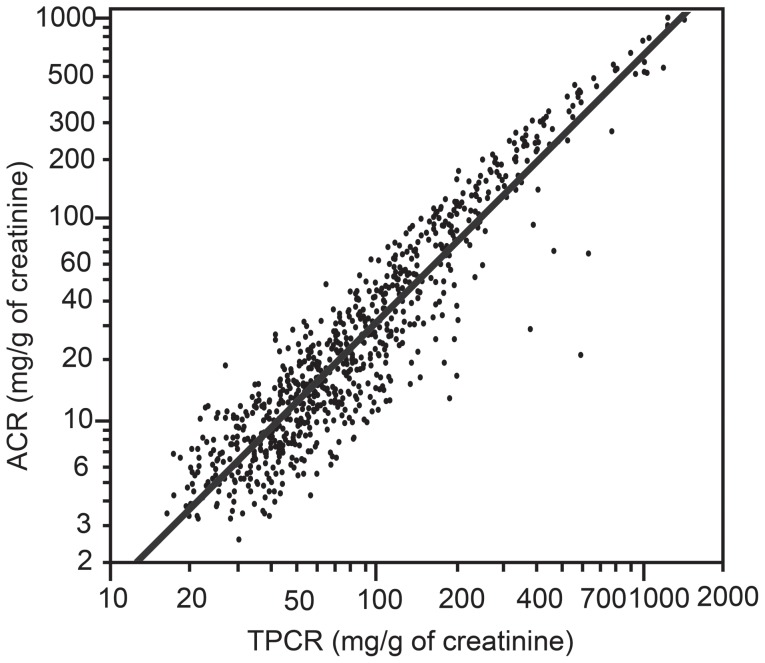
Correlation between the urine albumin-to-creatinine ratio (ACR) and the total urine protein-to-creatinine ratio (TPCR).All of the axes are on a logarithmic scale. The regression expression was written as follows: ln ACR = 1.32×ln TPCR – 2.64 [coefficient of determination R2 = 0.861 (p<0.001)].